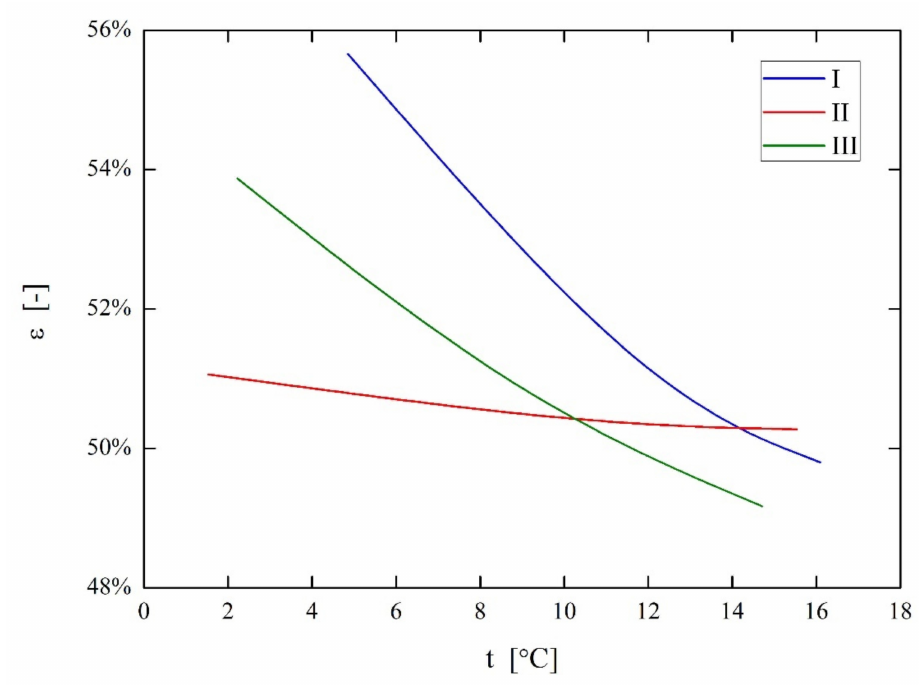
Figure 24. HEX temperature effectiveness vs. the fresh air inlet temperature for different volumetric flow